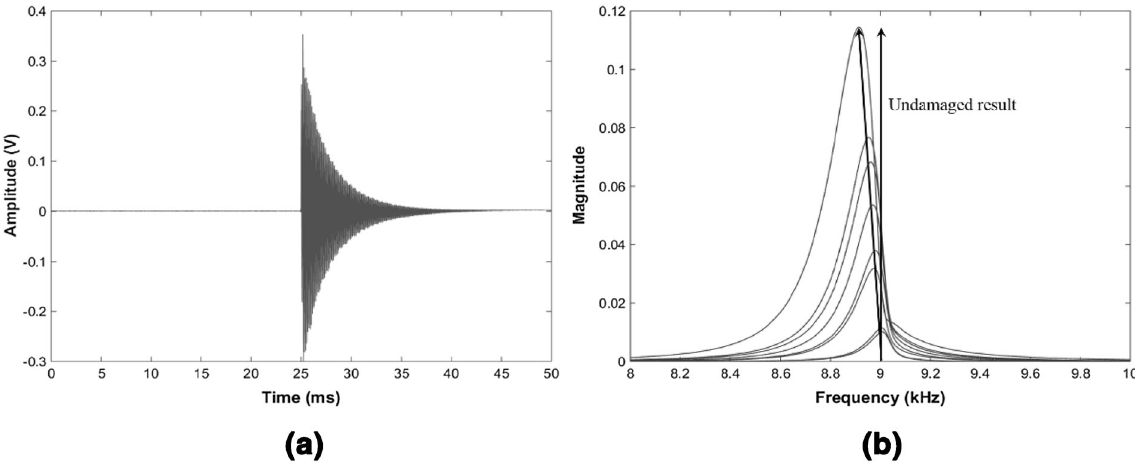
Fig. 2 Representative results of vibration signal and the amplitude-dependent resonance frequency shift of damaged concrete. a Vibration signal and b FFT.